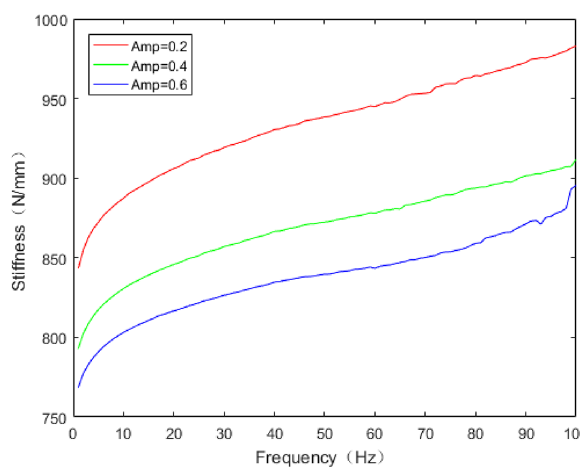
Figure 10. Relationship between radial stiffness and frequency in